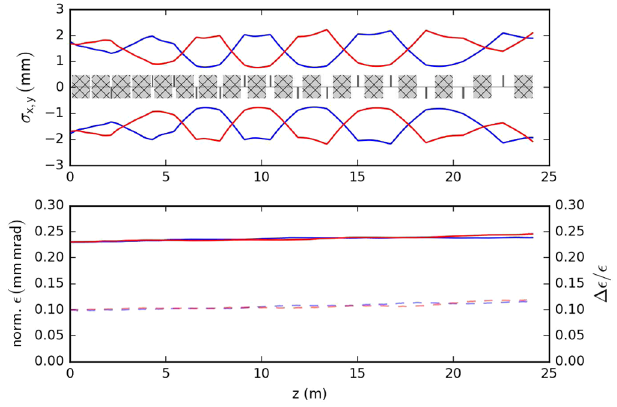
FIG. 6. rms beam envelope for the first pass using 6D Gaussian initial distribution with 20 mA bunch current.